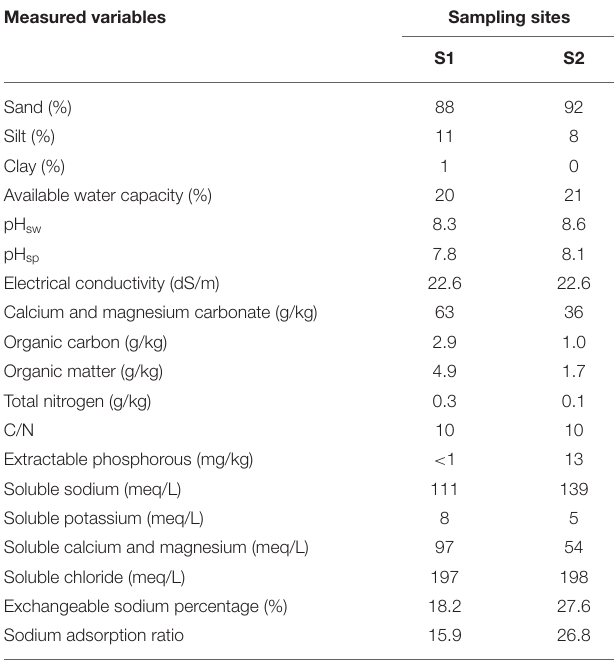
TABLE 1 | Physicochemical analysis of soil samples in both sampling sites: Site 1 (S1) and Site 2 (S2) in the Salar del Hombre Muerto. Measured